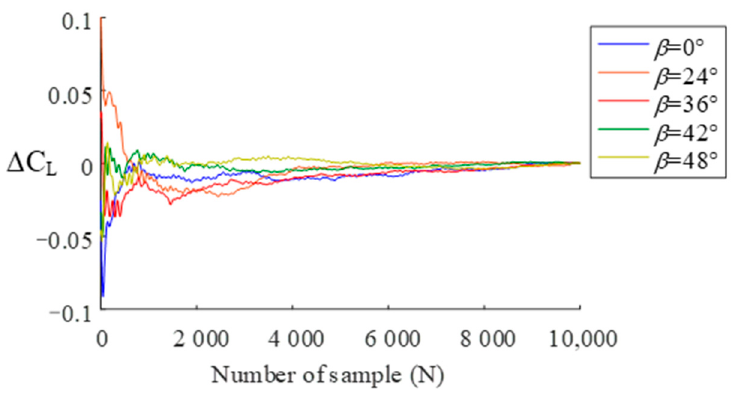
Figure 2. Ensemble average results at aspect ratio (AR) = 4.50 near the stall angle of attack.